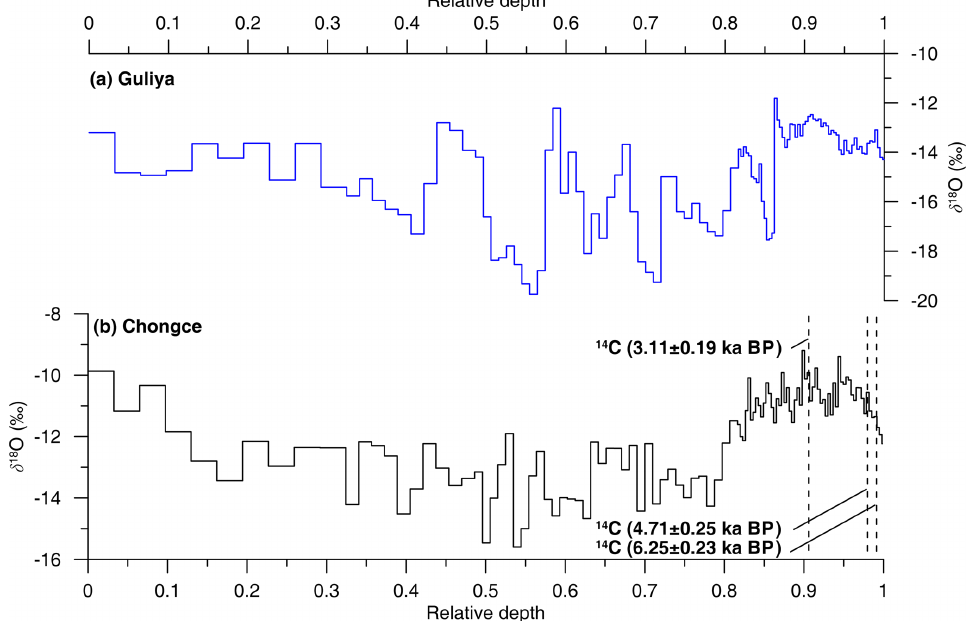
Figure 5. The δ 18 O profiles of the Guliya (a) and Chongce (b) ice cores, plotted against their relative depth. The Chongce profile was averaged to match the temporal resolution of the published Guliya record, as shown in Fig. 2a (Thompson et al., 1997). The Cryosphere, 13, 1743–1752, 2019